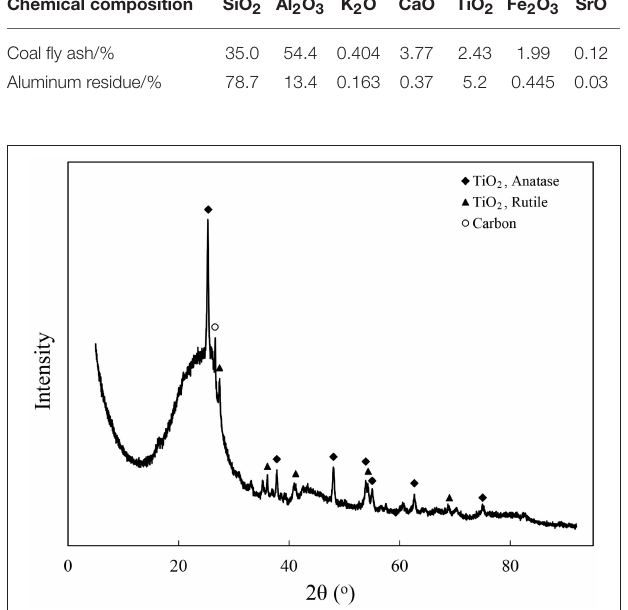
FIGURE 2 | XRD diffraction pattern of aluminum residue.